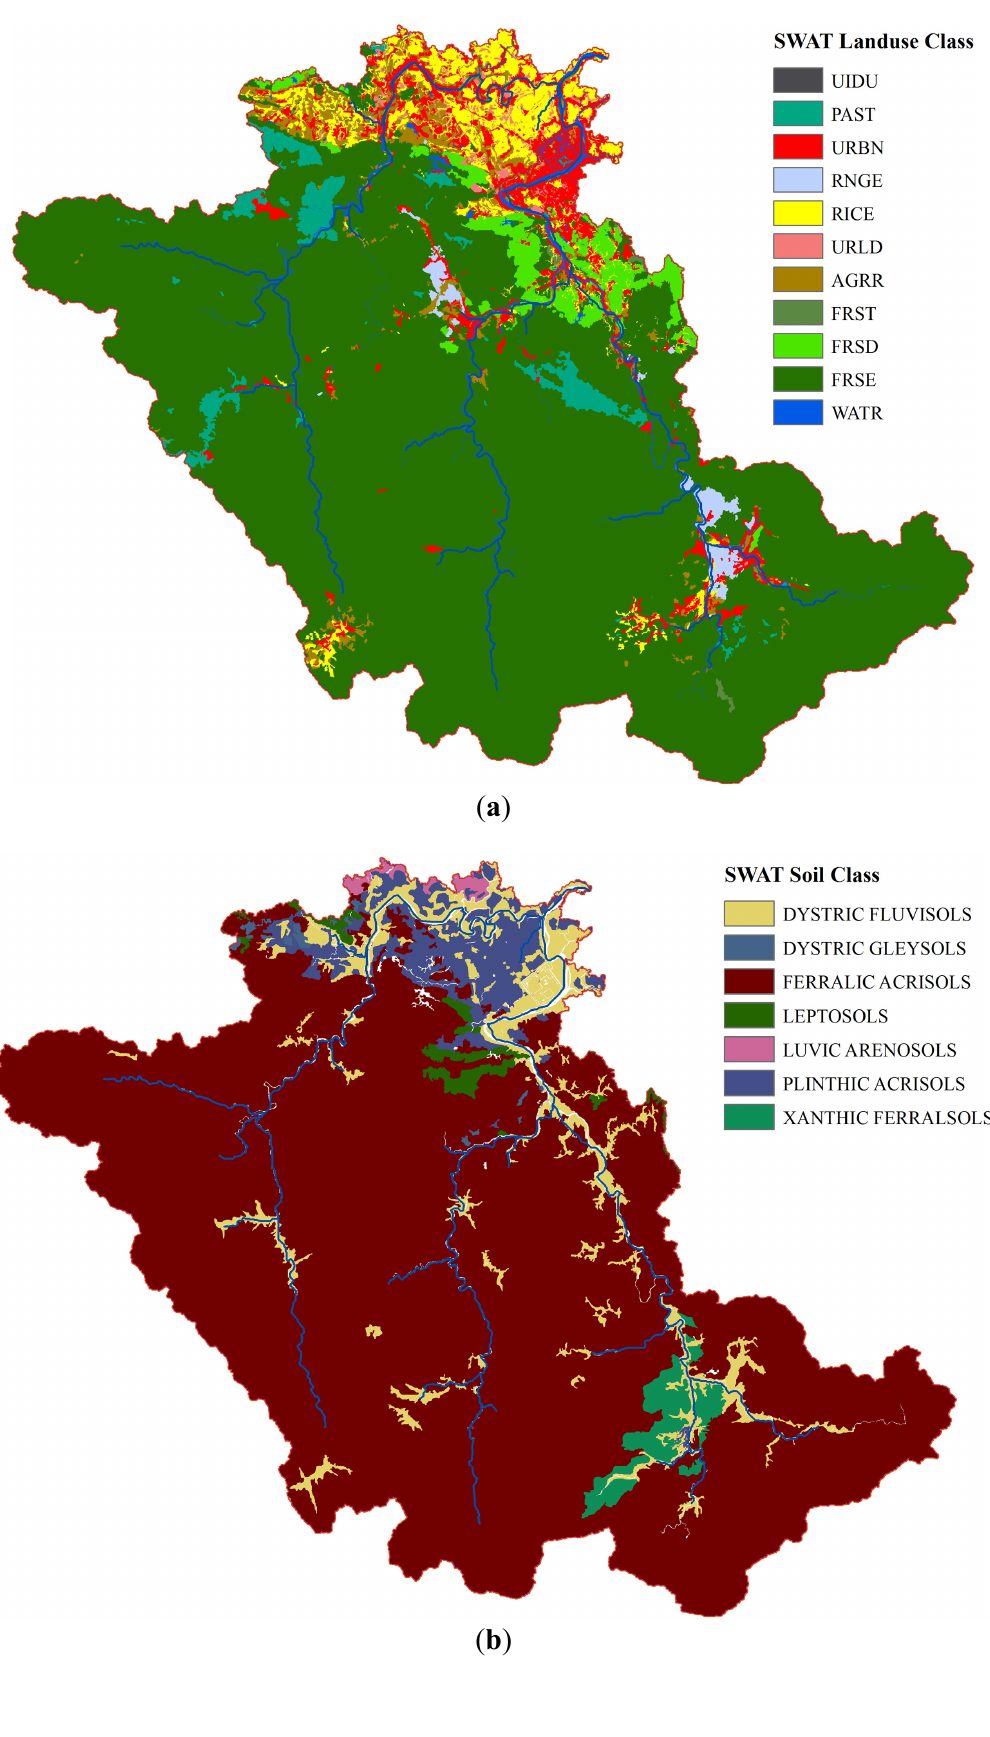
Figure 2. Land use ( a ) and soil ( b ) classes in the Huong River